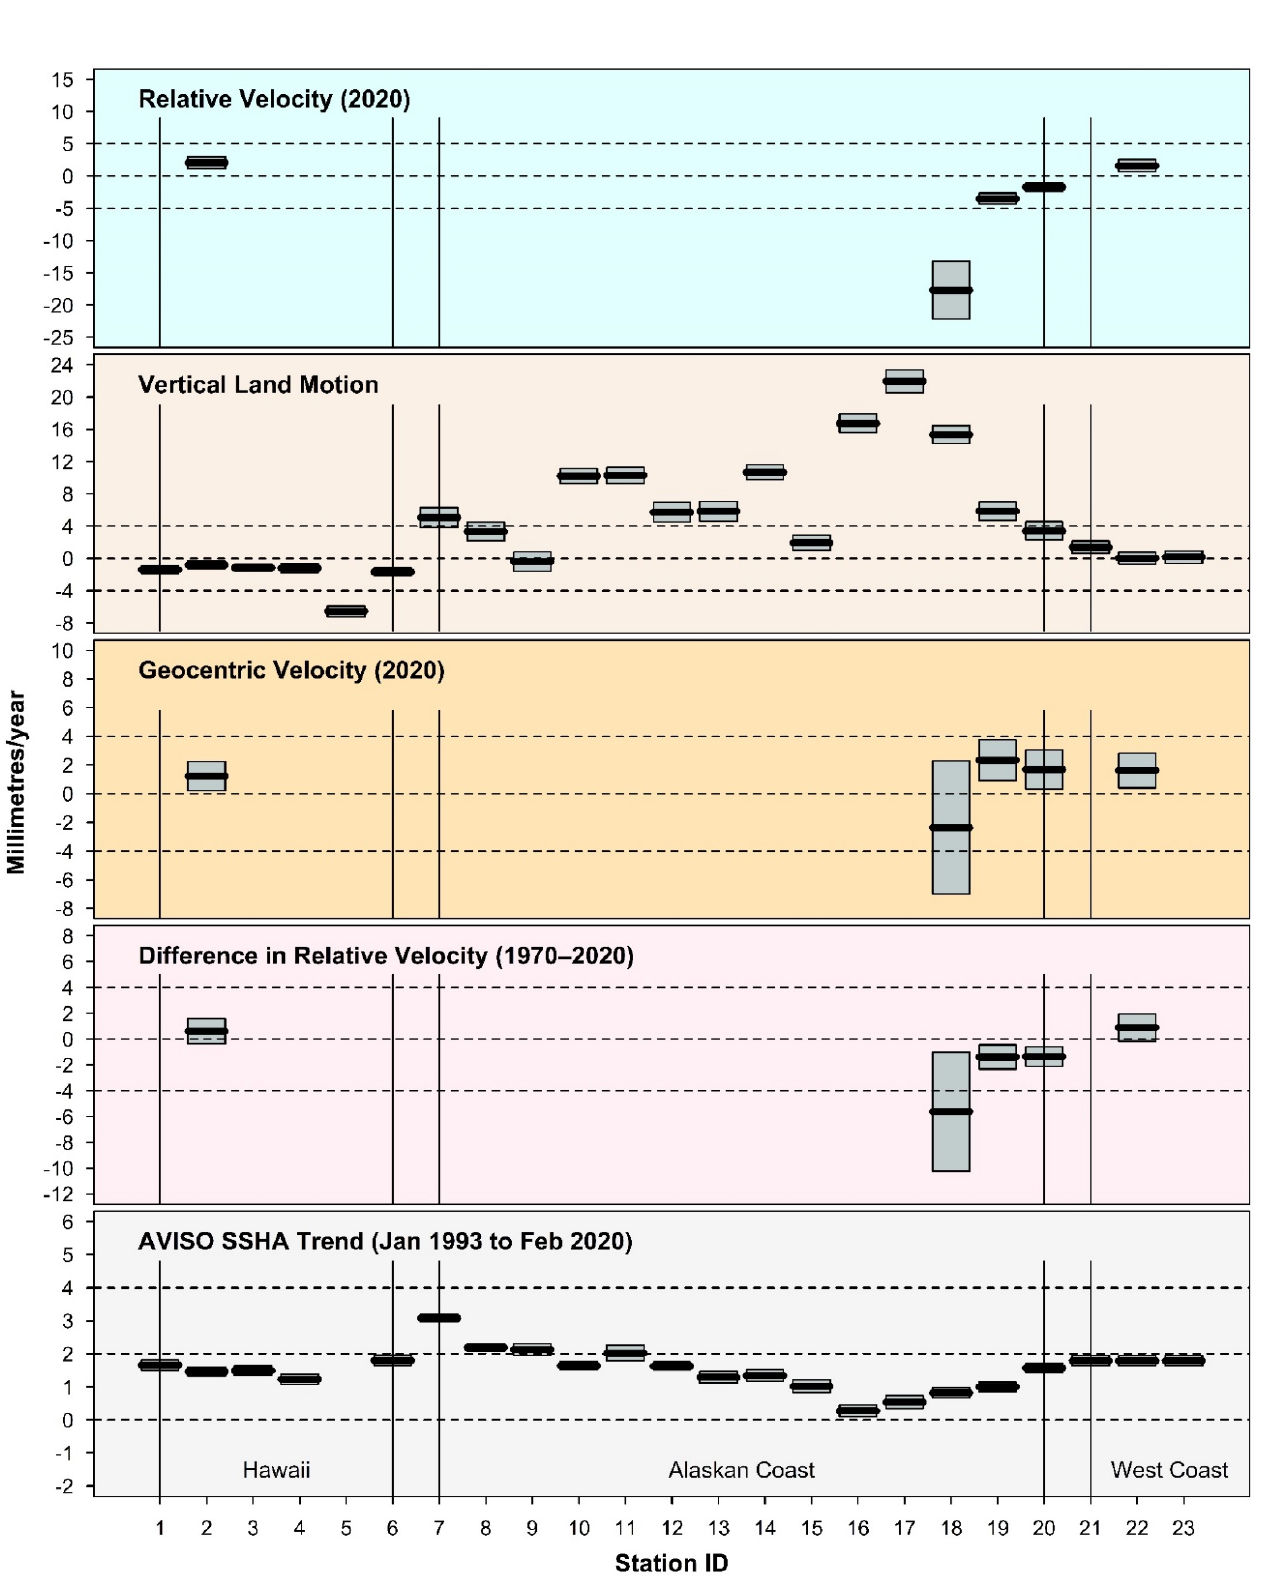
Figure 2. Summary of results for Station ID’s 1–23. Refer to Figure 1 and Table 1 for station ID details. Shaded boxes represent 95% CL for each set of results. Vertical lines demarcate respective sectors of coast which are denoted in the bottom panel. For details on the methodology underpinning the respective charts, refer Section 2.